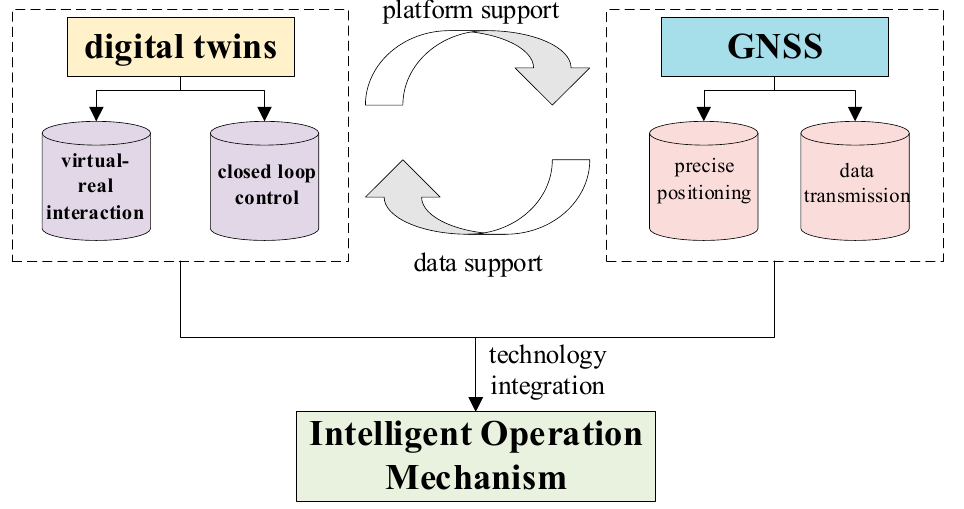
Figure 3. Fusion mechanism of GNSS and DTs.